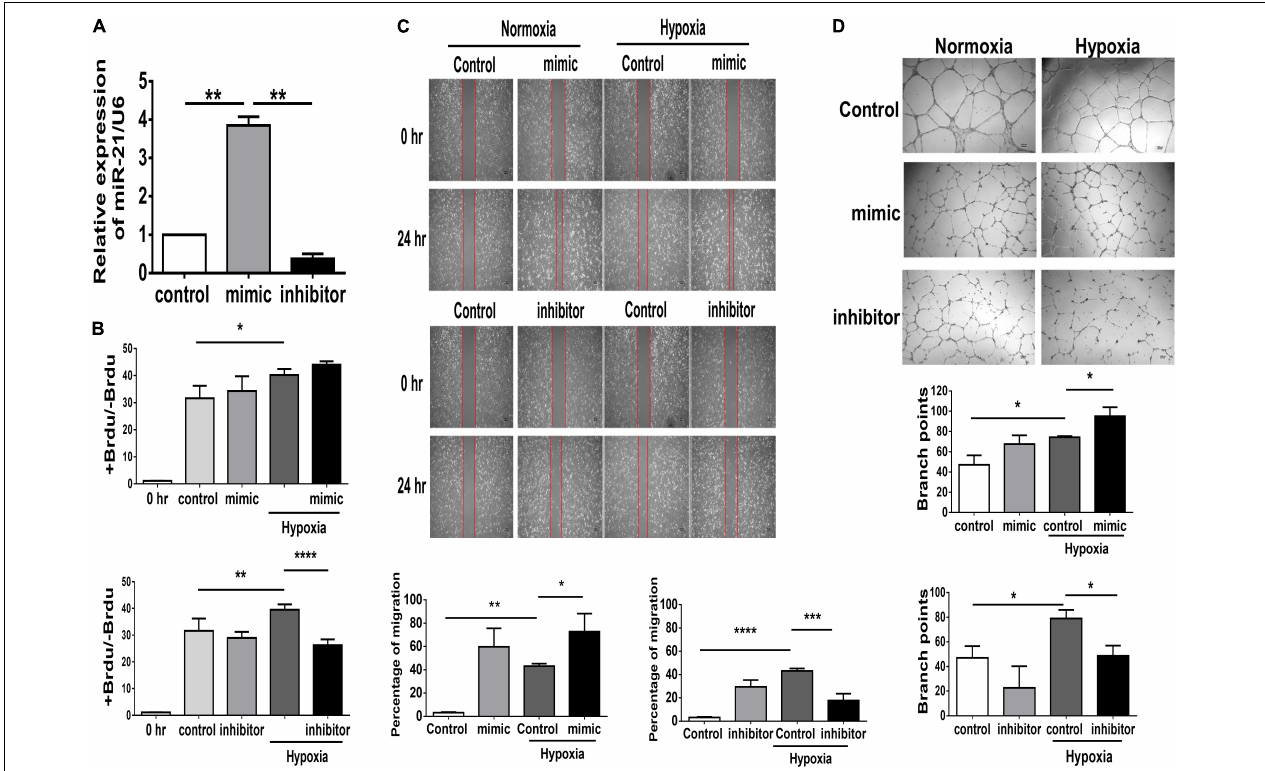
FIGURE 3 | Suppression of miR-21 attenuates proliferation, migration and tube formation in human umbilical vein endothelial cells (HUVECs). HUVECs were transfected with miR-21 mimic or inhibitor for 24 h before hypoxia stimulation. (A) The intracellular expression of miR-21 in HUVECs was determined by RT–qPCR. (B) Cell proliferation, evaluated by measuring BrdU incorporation into cells, (C) cell migration after 24 h, (D) tube formation, evaluated by the branched points in HUVECs pretreated with miR-21 mimic or inhibitor under hypoxia stimulation for 24 h. The experiment was conducted in triplicate, * P < 0.05, ** P < 0.01, and *** P = 0.001, and **** P <